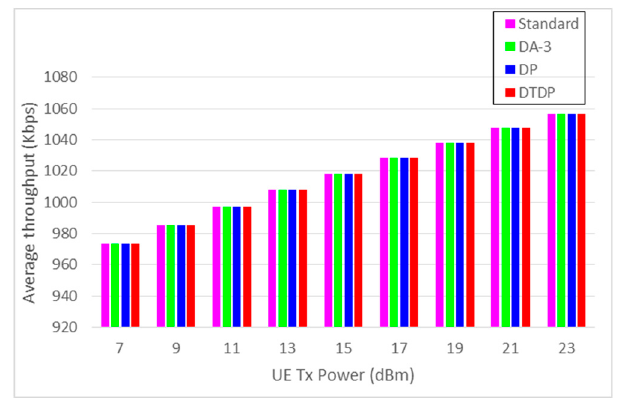
Figure 8. System throughput versus user equipment (UE) transmission power.